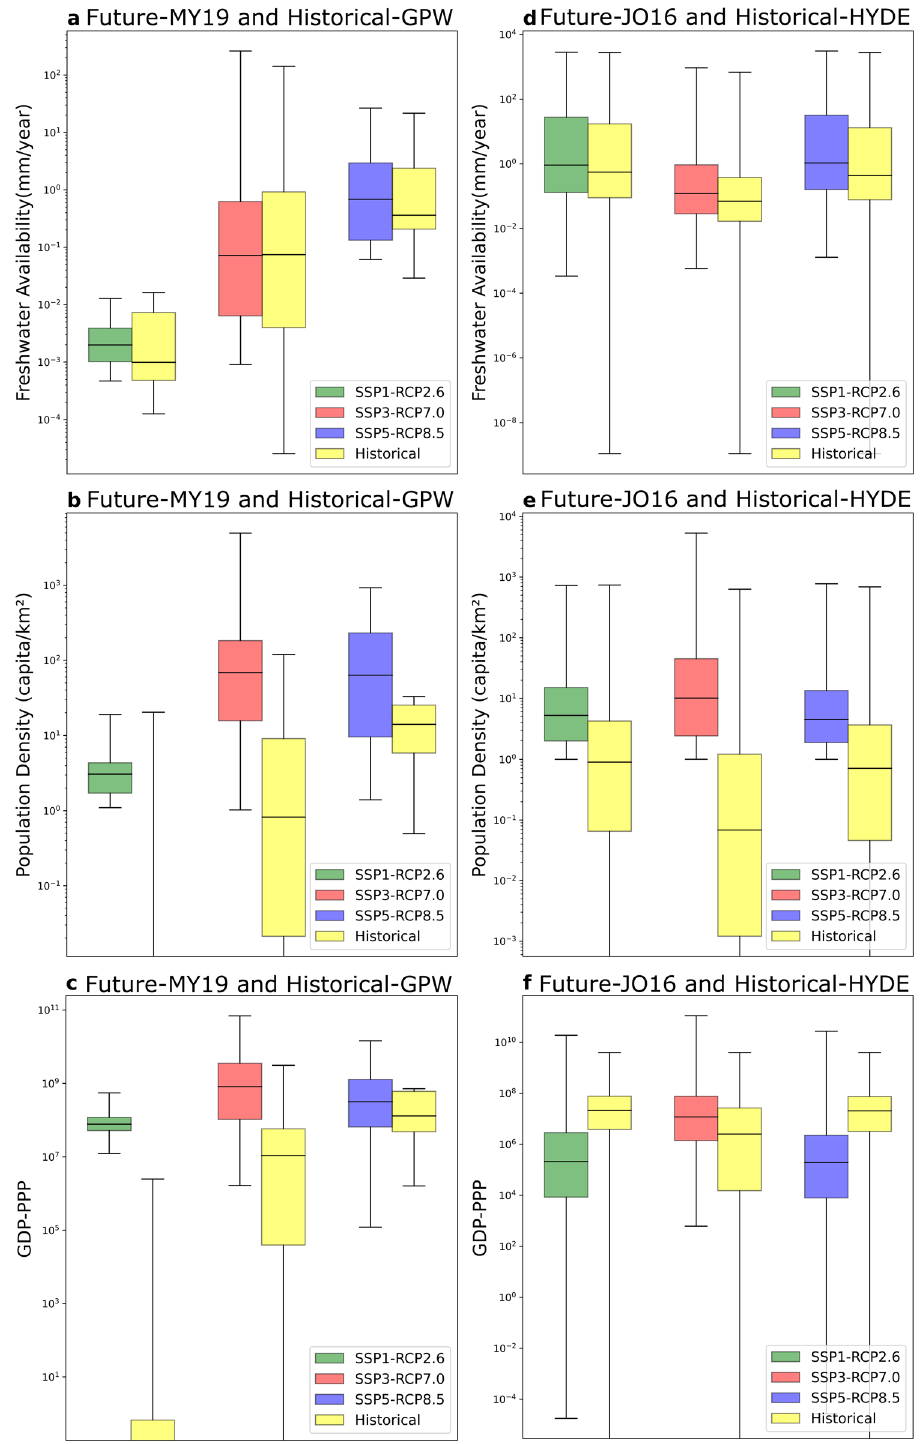
Fig. 4 Comparison of new water-scarce grids (i.e., grids facing physical and economic water scarcity in the future but not in the past). Box plots comparing the absolute values of ( a ), ( d ) freshwater availability (mm/year); ( b ), ( e ) population density (capita/km 2 ); and ( c ), ( f ) GDP-PPP. The analysis for ( a ), ( b ), and ( c ) was performed considering the Future-MY and Historical-GPW Experiment settings, and that of ( d ), ( e ), and ( f ) was performed considering the Future-JO and Historical-HYDE experiment settings (Supplementary Table 1). The error bars show the 100% con fi dence interval (i.e., 0 th and 100 th percentile), the bottom and top of the box are the 25 th and 75 th percentiles, and the line inside the box is the median (50 th